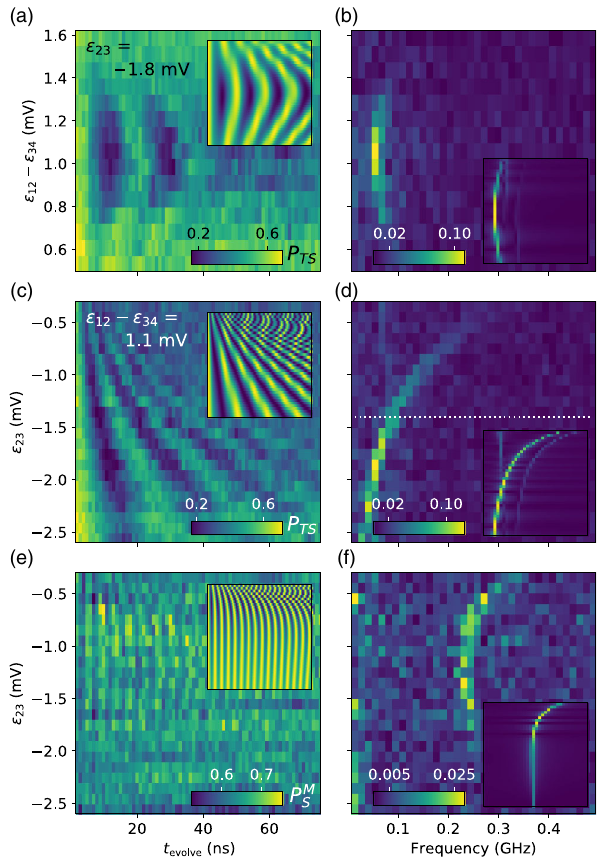
FIG. 3. Global coherent exchange oscillations. Coherent oscil- lations (a),(c) within the triplet subspaces and (e) within the singlet subspace. In (a), the difference in left- and right-pair detuning is varied, and in (c),(e), the middle-pair detuning is varied (with J 12 ¼ J 34 ). (b) Fourier transform of the data in (a). The frequency minimum corresponds to J 12 ¼ J 34 . (d) Fourier transform of the data in (c). At J 12 ¼ J 23 ¼ J 34 ¼ J dotted line, the most visible frequency is equal to J (f) Fourier transform of the data in (e). The frequency minimum corresponds to J 12 ¼ J 23 ¼ J 34 ¼ J Insets in all panels show numerical simulations of the